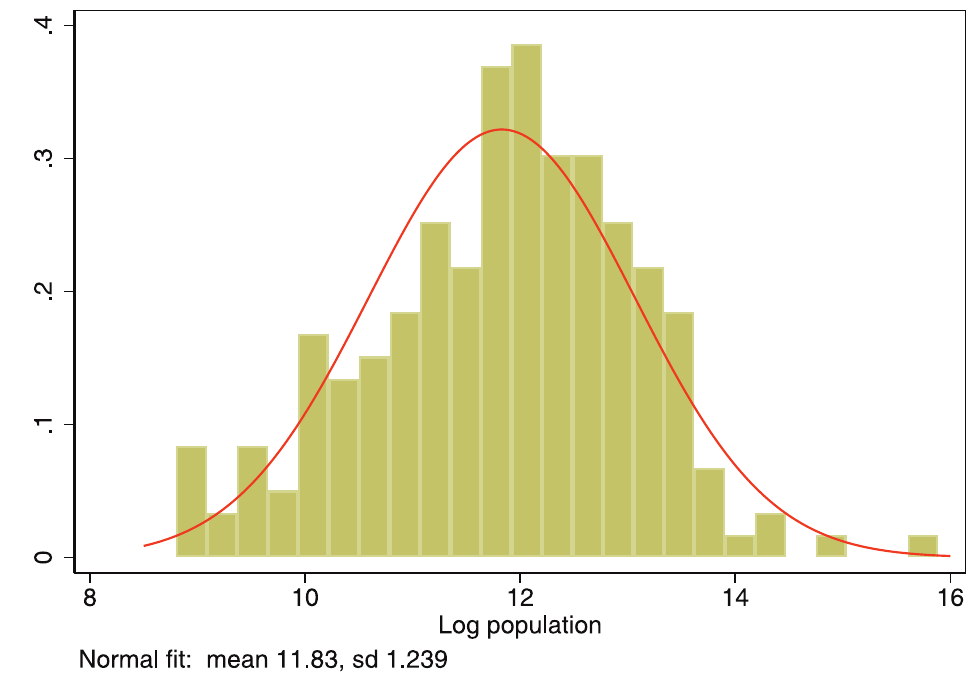
Fig 8. The size distribution of cities (UK travel to work